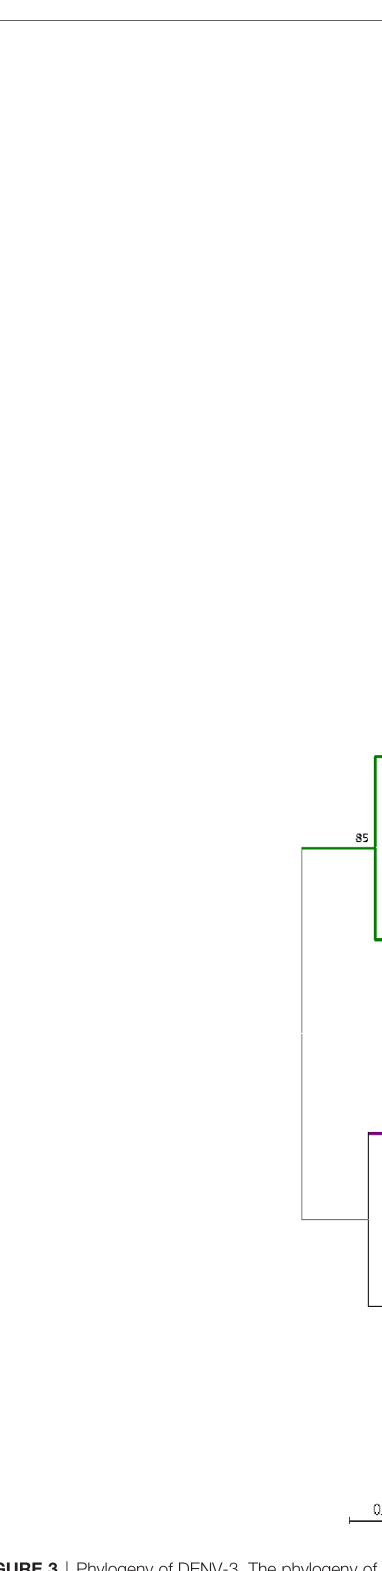
FIGURE 3 | Phylogeny of DENV-3. The phylogeny of DENV-3 was inferred by using the ML method. The tree with the highest log likelihood (-1,018.14) is shown. The analysis involved 63 nucleotide sequences. There was a total of 255 positions in the fi nal dataset. The two sequences (MDU11 and MDU100) from this study were grouped under genotype III. Nucleic acid substitution per position was calculated as